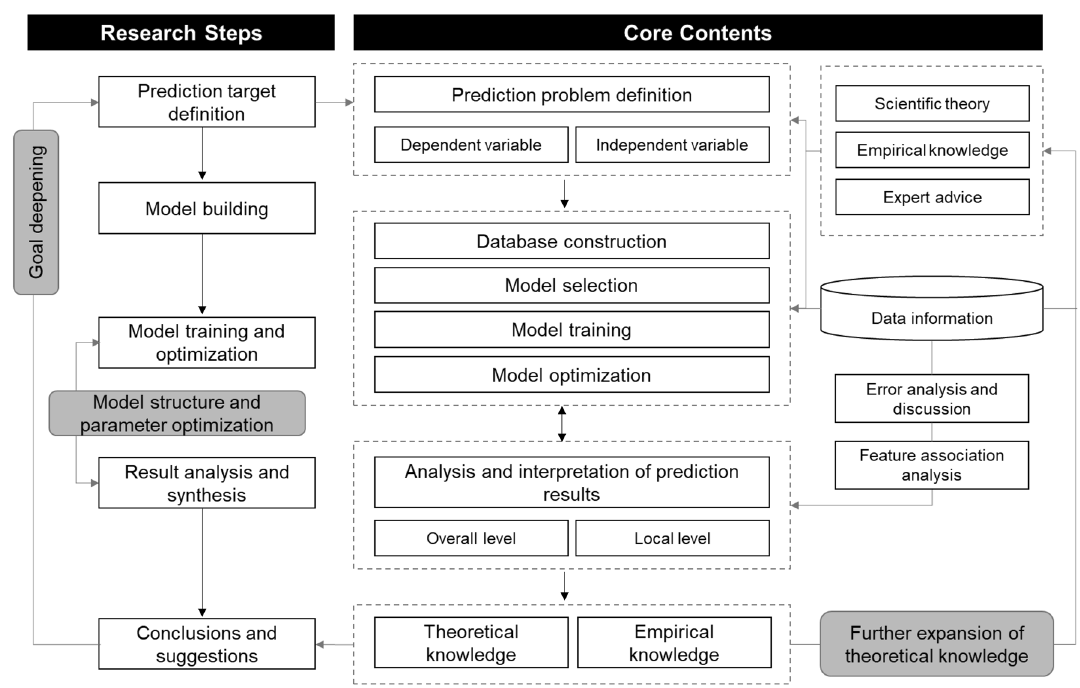
Figure 2. Prediction model framework of spatial–temporal crowd density. Source Author